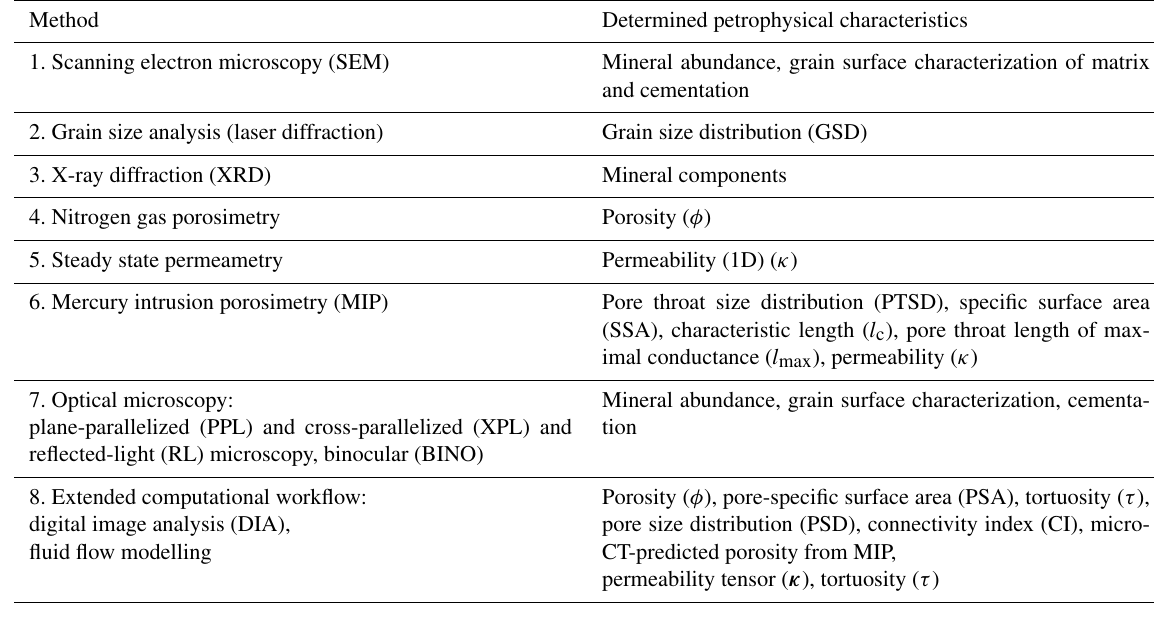
Table 1. Laboratory methods employed and petrophysical characteristics determined from these methods.